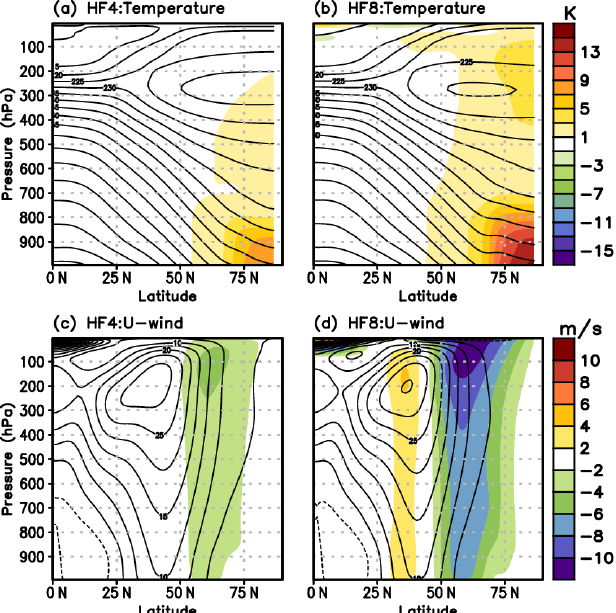
Figure 1. Time-mean zonally averaged ( a , b ) temperature (contours) and deviation (shaded) from control experiment, contour intervals are 10 K, and ( c , d ) zonal wind (contours) and deviation (shaded) from control experiment, contour intervals are 5 m/s.